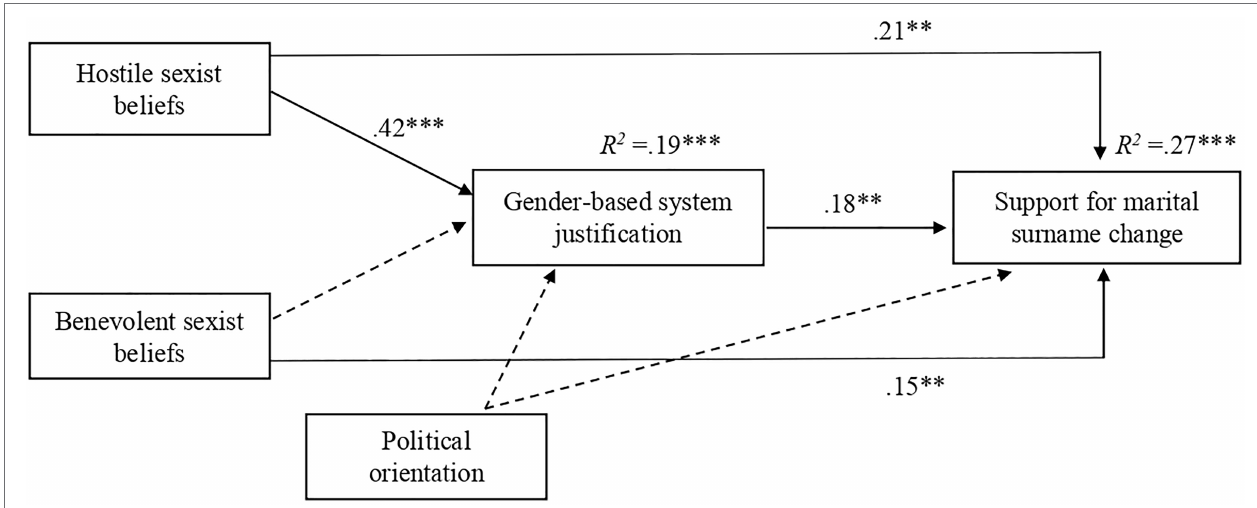
FIGURE 4 | The results of mediation analysis in Study 3. Standardized regression coefficients for the relationship between hostile and benevolent sexism (IVs) and support for marital surname change (DV) as mediated by gender-based system justification and controlled for political orientation, *** p < 0.001, ** p < 0.01. Non-significant paths are shown as broken